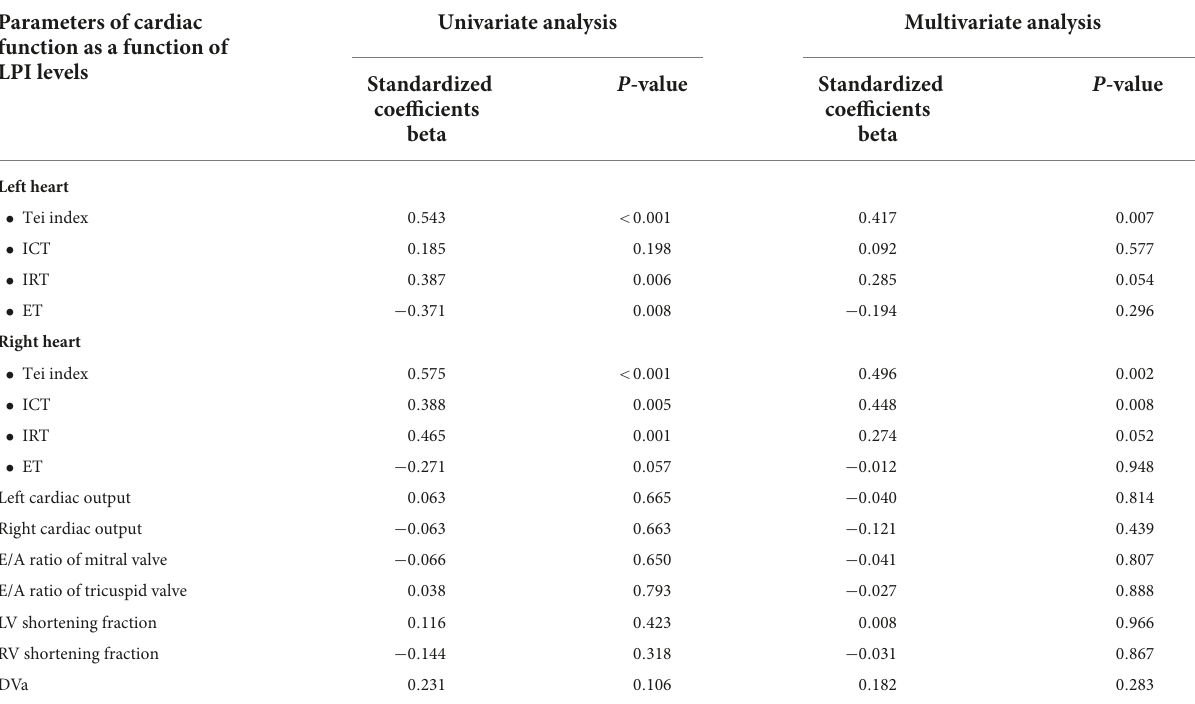
TABLE 4 Correlation between fetal LPI (Labile Plasma Iron) levels and cardiac function based on univariate analysis and multivariate analysis (adjusted for maternal age, gestational age, hemoglobin; mean corpuscular volume; reticulocyte count; nucleated red blood cell; white blood cell count; platelet count; mean platelet volume; and immature platelet